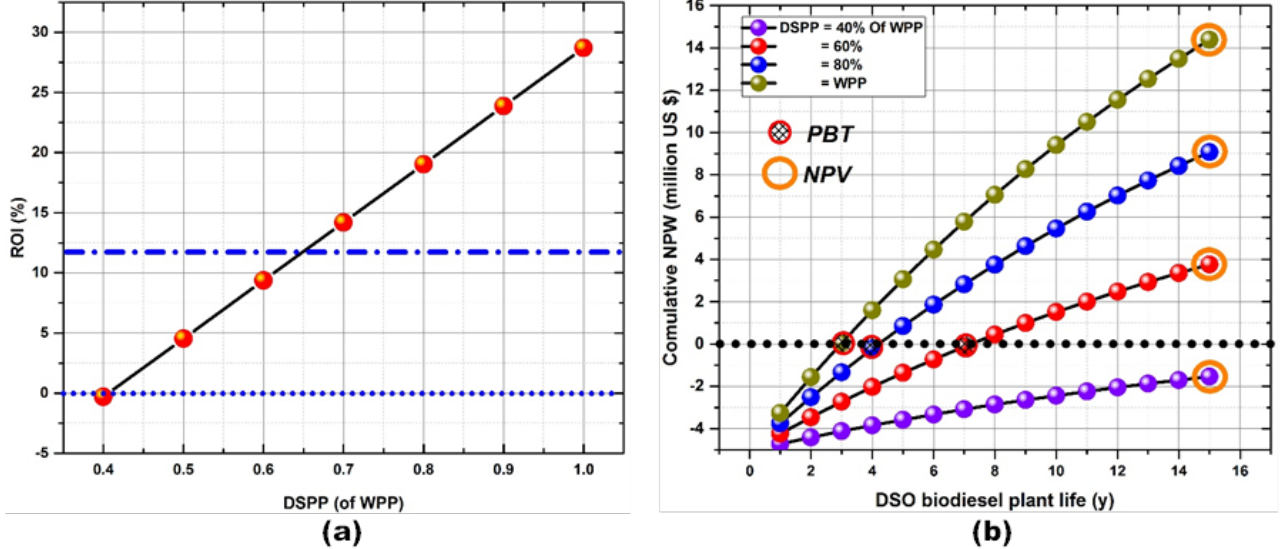
Figure 5. Economic performance analysis of the 1000 t/y DSO biodiesel plant by: ( a ) ROI vs. DSPP as % WPP (blue lines mark 0 and the acceptable 12% level) and ( b ) PBT and NPV by plant lifetime for four DSPP values.